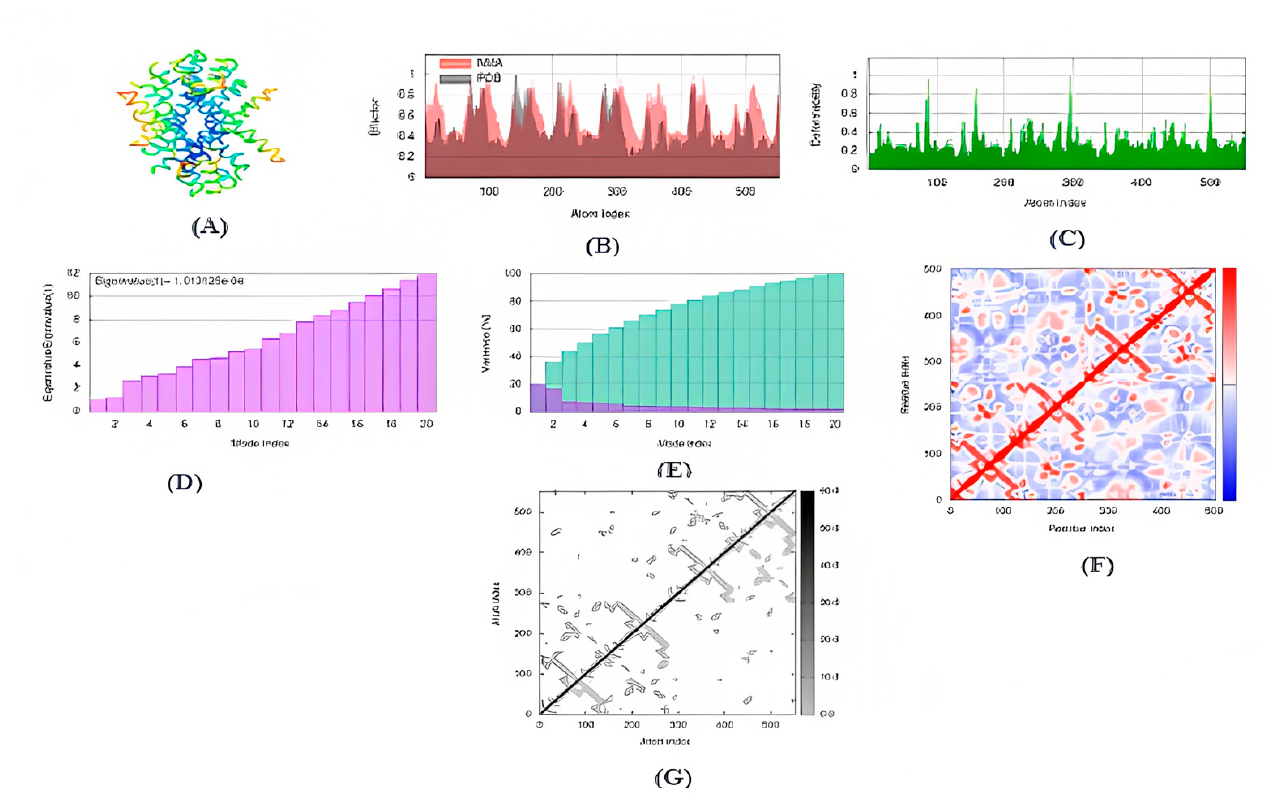
Figure 11. Docked complex of AIGT and BCR-ABL1 molecular dynamic stimulation. ( A ) MNA mobility of 3D structure ( B ) AIGT and BCR-ABL1 docked complex deformability ( C ) B-factor of AIGT and BCR-ABL1 docked complex ( D ) Docked complex AIGT and BCR-ABL1 Eigenvalues ( E ) Docked complex AIGT and BCR-ABL1 variance where individual deviations are shown in purple color, and collective variances are shown in green ( F ) Docked complex AIGT and BCR-ABL1 co-variance map in which the red color shows the correlated area and the blue color depicts anti-correlated motions ( G ) Docked complex AIGT and BCR-ABL1 elastic network where more stiff regions are shown as darker grey in color.